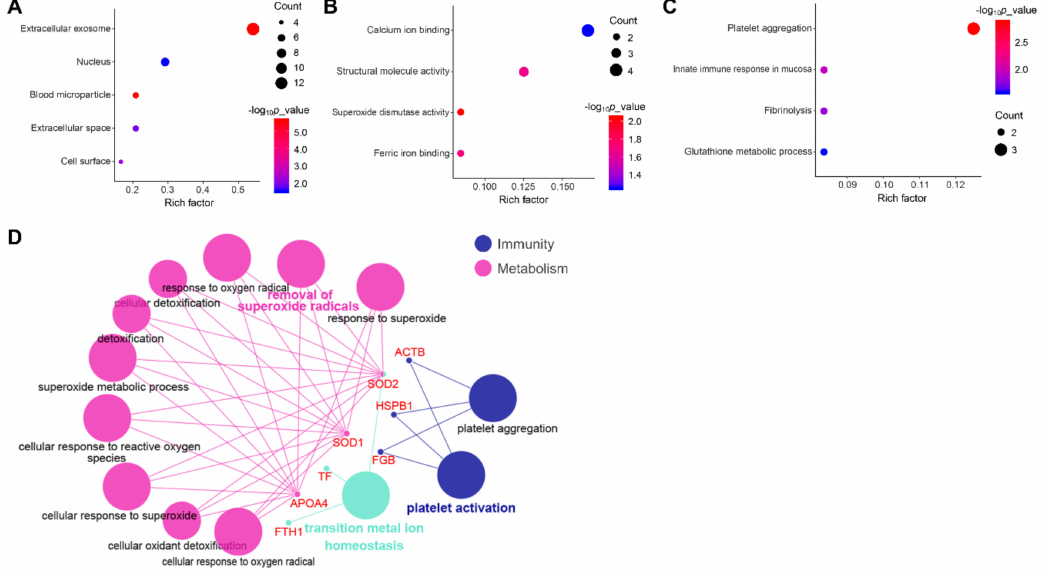
Figure 3. Gene Ontology (GO) annotation of DEPs. GO enrichment analyses of di ff erentially expressed proteins involved in ( A ) cellular component; ( B ) molecular function, and ( C ) biological process from the Database for Annotation, Visualization and Integrated Discovery (DAVID) database; ( D ) GO analyses of DEPs involved in biological processes using Cytoscape software.